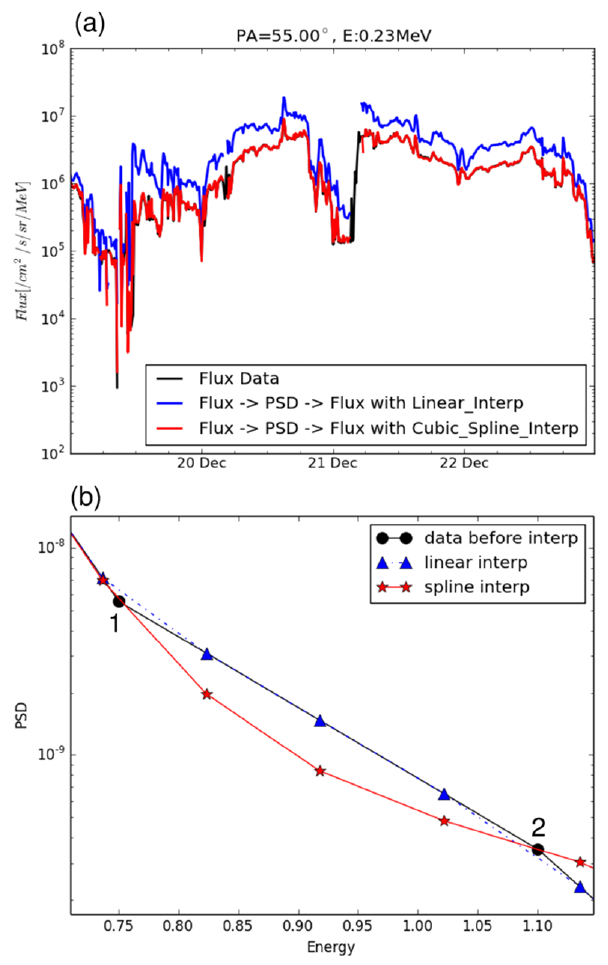
Fig. 1. (a) Comparisons between original flux data (black) and re- versely inverted flux from the phase space density (PSD) informa- tion, which has been previously converted from the original flux data. The conversion between the flux and PSD utilizes a cubic spline interpolation (red) or a linear interpolation method (blue) within the energy spectrum. (b) The illustration of the two meth- ods in interpolating the PSD over an energy spectrum. When the reverse inversion is converted, the newly interpolated data at point 1 using the linear method is above the original black dot (on the dash line). This is however the opposite at point 2 when the energy spectrum has a convex